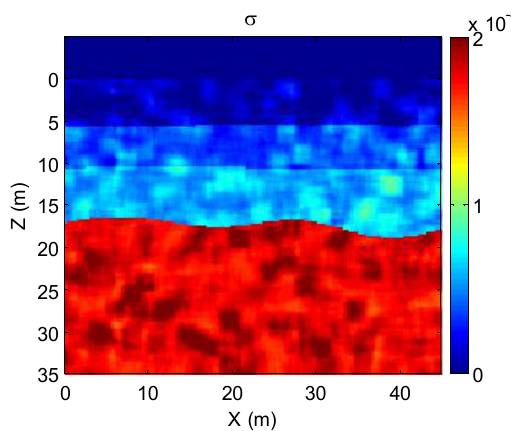
Figure 4. Relative conductivity model The data below the ice surface is taken as test data (Figure 5a) and processed by VMD. VMD is performed to obtain the five IMF components in Figure 5b-f, where IMF1, IMF3, and IMF4 are the main noise components, and the main useful information is stored in IMF2 and IMF5. Therefore, the composite profile of the component IMF2 and the IMF5 is obtained as shown in Figure 6. From the comparison of Figure 5a with Figure 6 we can see, the latter is apparently clearer. The VMD method eliminates a large amount of noise. Through the elimination and recombination, the signal-to-noise ratio of the whole data is significantly improved.